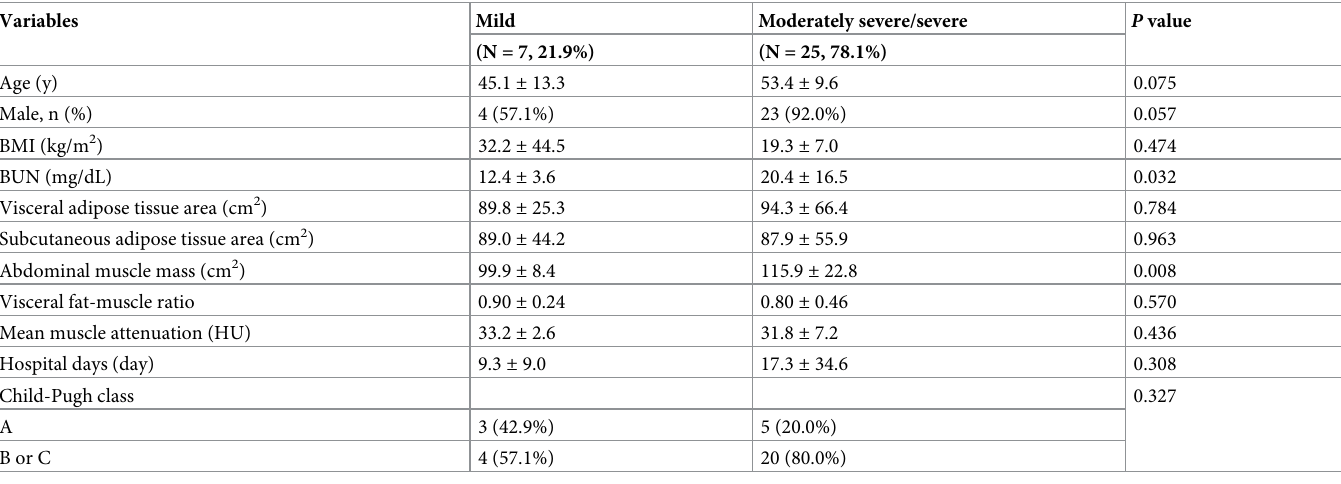
Table 4. Characteristics of cirrhotic patients with alcoholic acute pancreatitis (N =